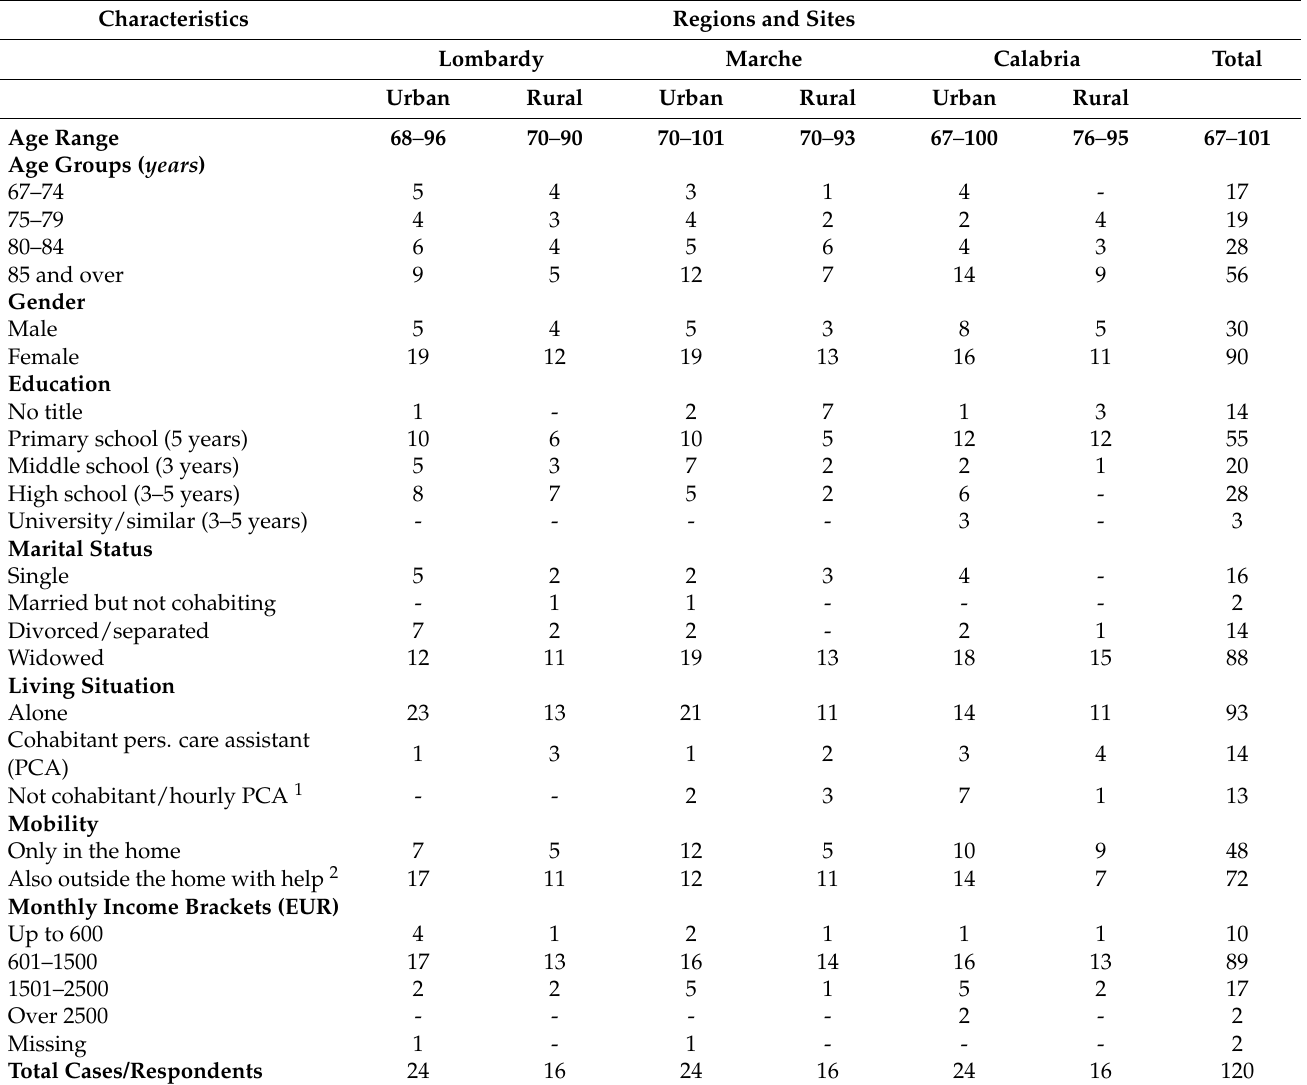
Table 3. Sample Characteristics (absolute values/ n